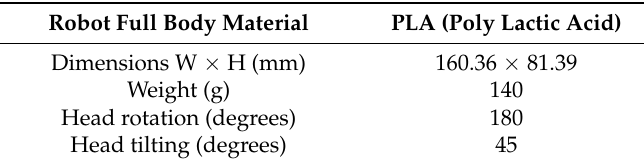
Table 1. Mechanical properties of wearable KiliRo